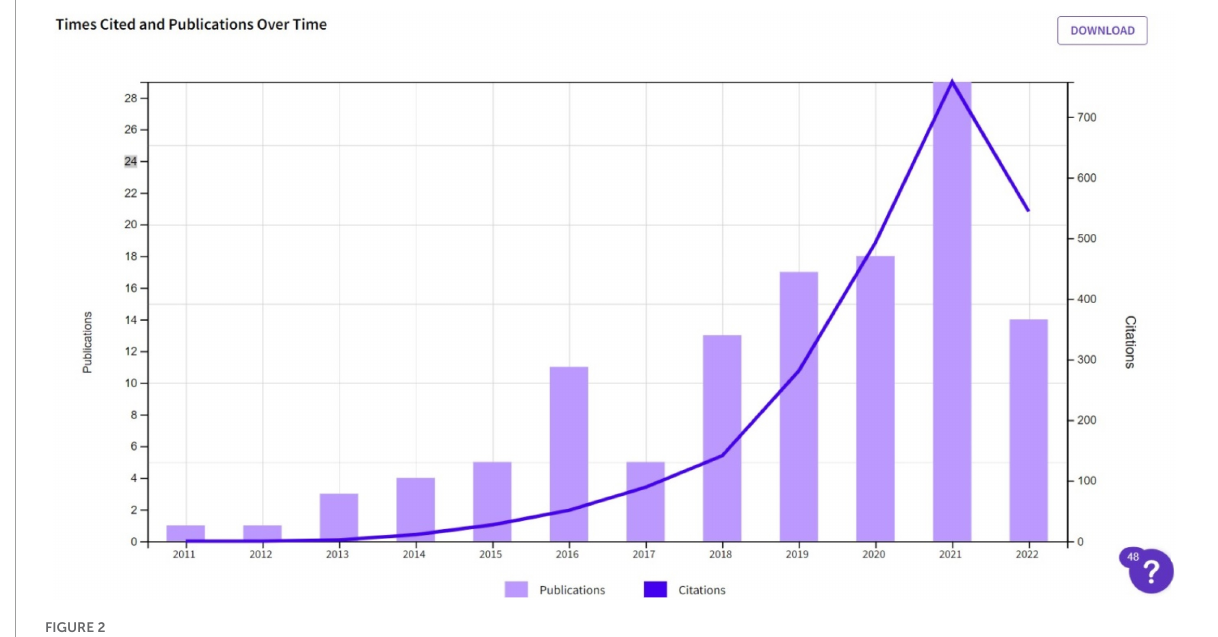
FIGURE2 Citations and publications per year. Reproduced with permission of